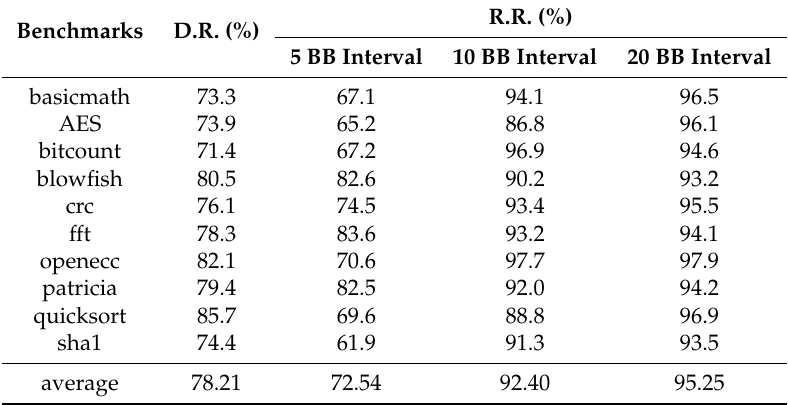
Table 4. Detection and recovery rating for buffer overflow on two stack frames.